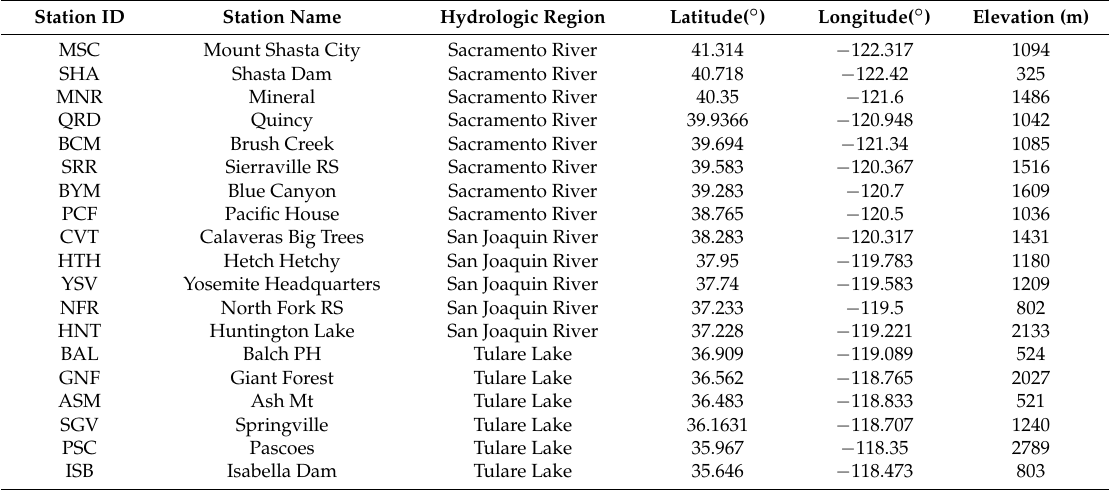
Table A1. Precipitation gauges applied in calculating precipitation